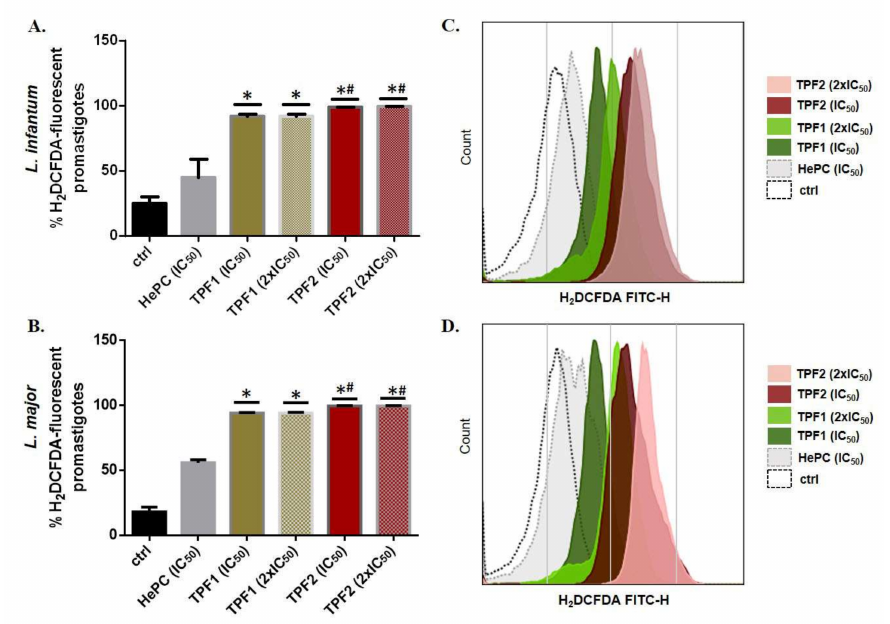
Figure 4. Intracellular ROS levels in TPF1- and TPF2-treated Leishmania spp. promastigotes. Log- phase L. infantum and L. major promastigotes were treated with TPF1 and TPF2 at IC 50 and 2 × IC 50 doses for 72 h. HePC (IC 50 )-treated and untreated parasites were used as positive and negative control groups, respectively. ROS levels were quantified using H 2 DCFDA and flow cytometry. Data are presented as mean values of H 2 DCFDA-fluorescent L. infantum ( A ) and L. major ( B ) promastig- otes ( ± SD) in bar diagrams, and as single parameter histograms (FITC-H) for L. infantum ( C ) and L. major ( D ). The symbol of * indicates significant differences compared to the positive control group. Differences between TPF1- and TPF2-treated parasites are indicated with